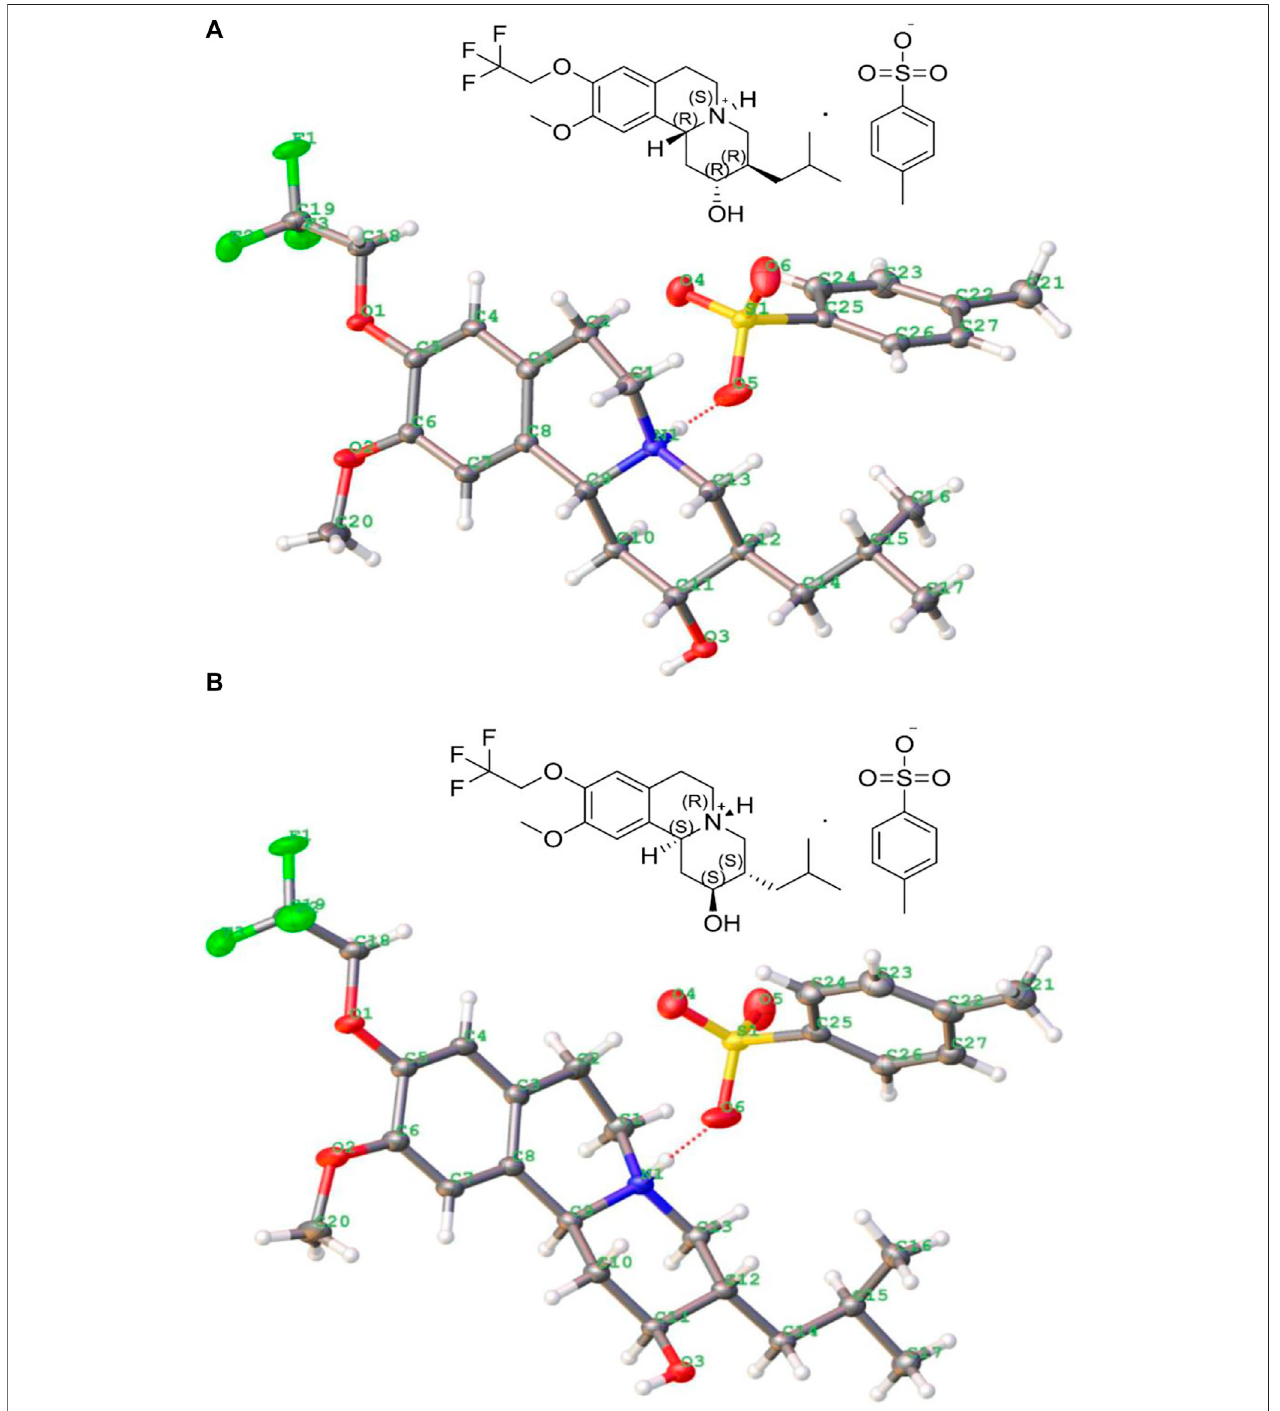
FIGURE 2 | Crystal structures of p -toluenesulfonate of (+)-9-tri fl uoroethoxy- α -dihydrotetrabenazine [(2 R ,3 R ,11b R ) isomer, (+)-13e] (A) and p -toluenesulfonate of (2 S ,3 S ,11b S ) isomer [( − )-13e] (B) .